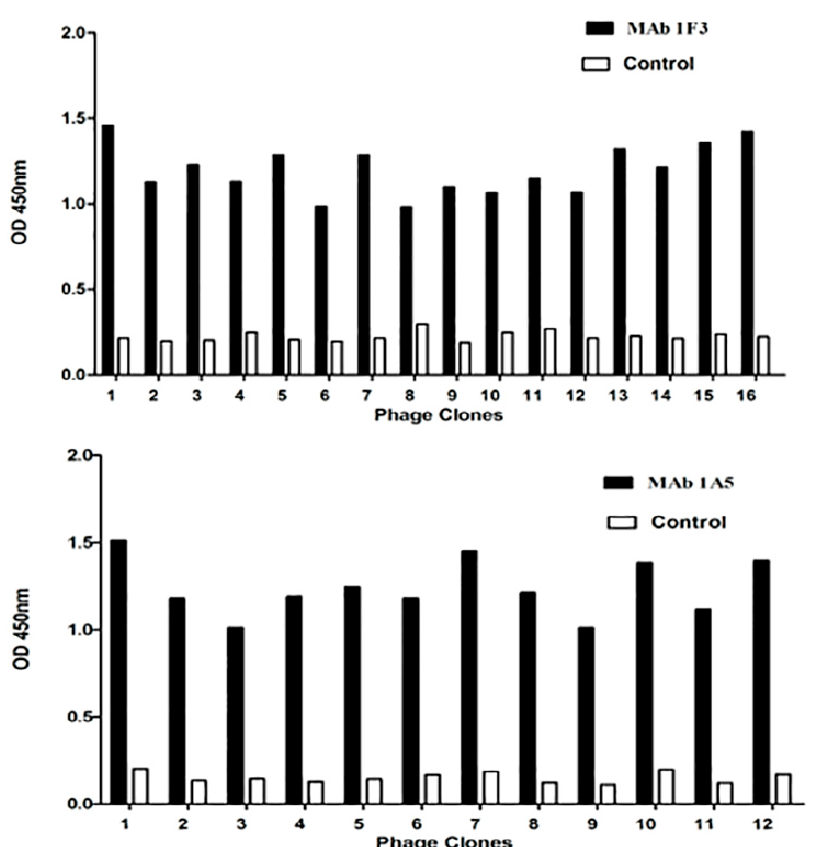
Figure 1. Detection of selected phages for monoclonal antibody (mAb) binding in the phage enzyme-linked immunosorbent assay (ELISA). The selected phage clones were detected by 1F3 and 1A5 or the anti-porcine interferon (IFN)-c mAb (negative control) after three rounds of biopanning. OD, optical density.